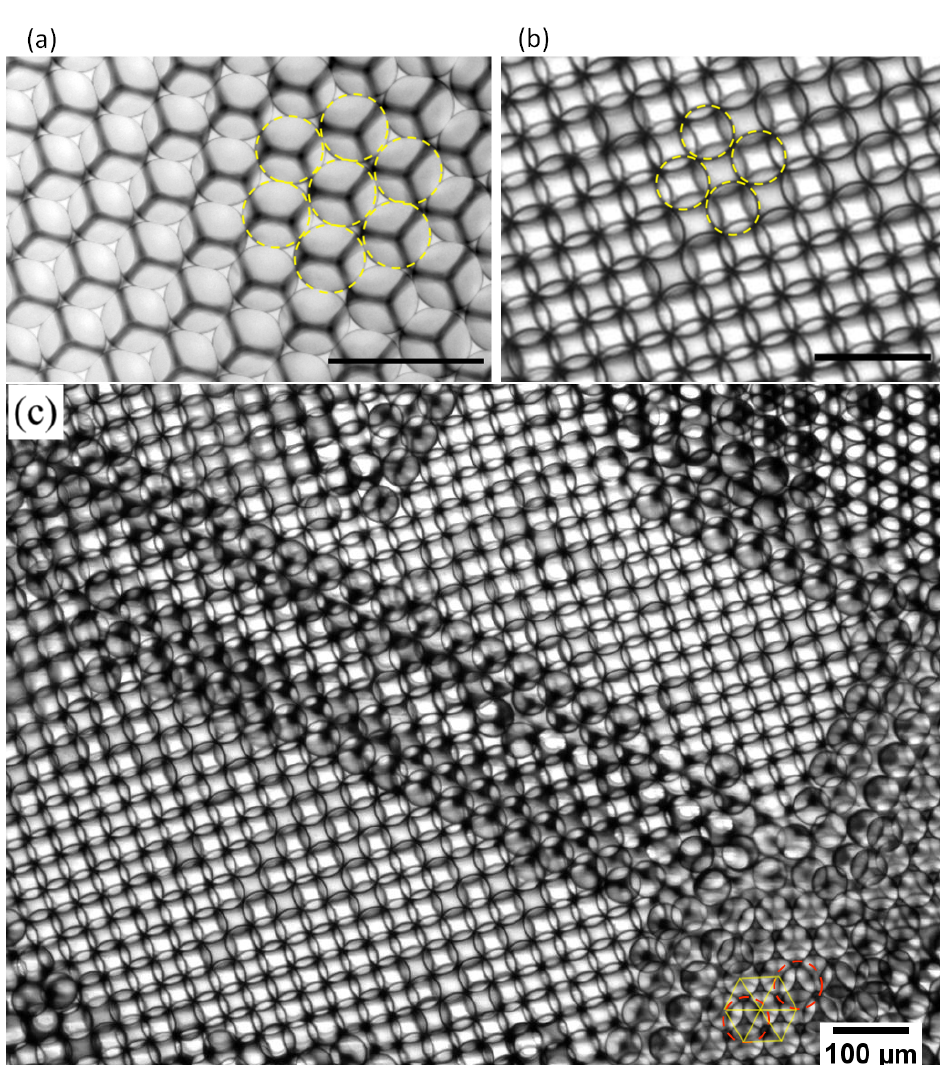
Figure 5. Optical microscopy images of two layers of ZnO NP droplets collected at the oil/air interface (in a Petri dish), showing standard hexagonal packing in the absence of rhodamine B dye ( a ) and an unexpected square organization when rhodamine B dye is added ( b , c ). This square organization highlights the existence of spontaneous electrical polarization within these droplets. Hexagonal organization may coexist with square organization, as seen in the lower right of the image shown in ( c ); see text for explanation. Scale bars: 100 µ m. See also Supplementary Materials Section (videos) for the visualization of the dynamics of the observed square organization of